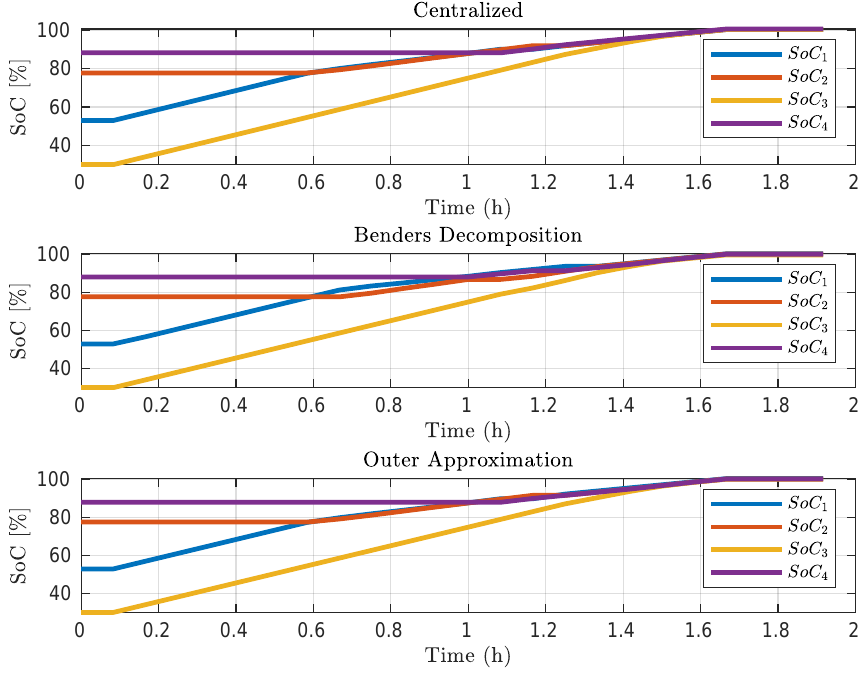
Figure 8. State-of-charge of the